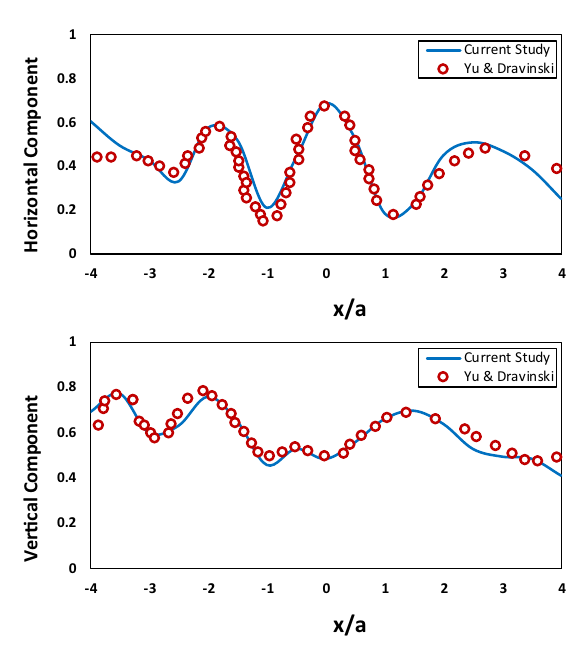
Fig. 6 Verification of horizontal and vertical displacement compo- nent of the present study with the results of Yu and Dravinski (η = 1, d/a =